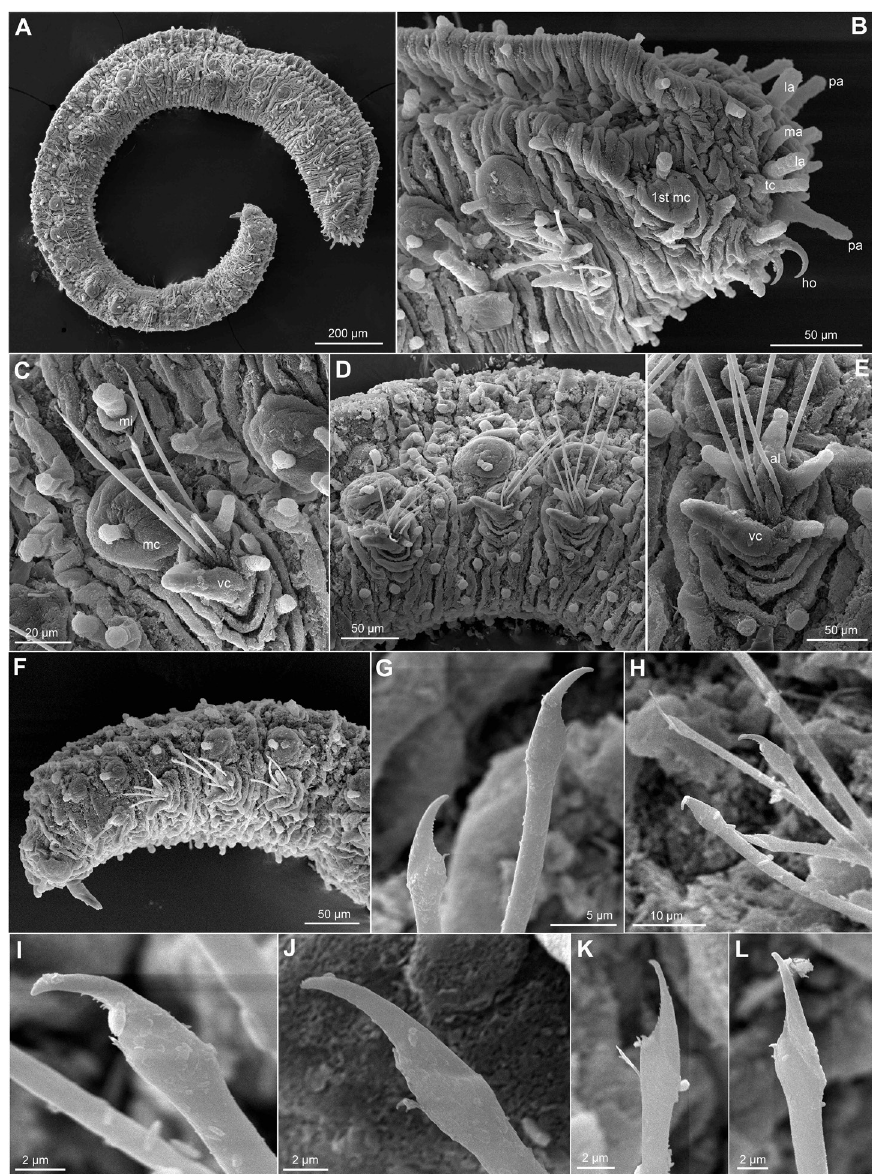
Figure 2. Ephesiopsis guayanae , USNM 1001777, SEM. A Whole specimen, side view B Anterior end, side view C Chaetiger 3, with parapodia, macrotubercle and microtubercle, side view D Mid-body seg- ments, side view E Mid-body parapodium showing detail of parapodial papillae, acicular lobe and ventral cirrus F Posterior chaetigers and pygidium with paired dorsal cirri and ventral digitiform anal cirrus, side view G Chaetae chaetiger 4 H Chaetae mid-body fascicle I–L Chaetae mid-body chaetigers. Abbrevia- tions: 1 st mc, macrotubercle from first chaetiger; al, acicular lobe; la, lateral antenna; ma, median antenna; mc, macrotubercle; mi, microtubercle; mo, mouth; no, nuchal organ; pa, palp; tc, tentacular cirrus; vc, ventral